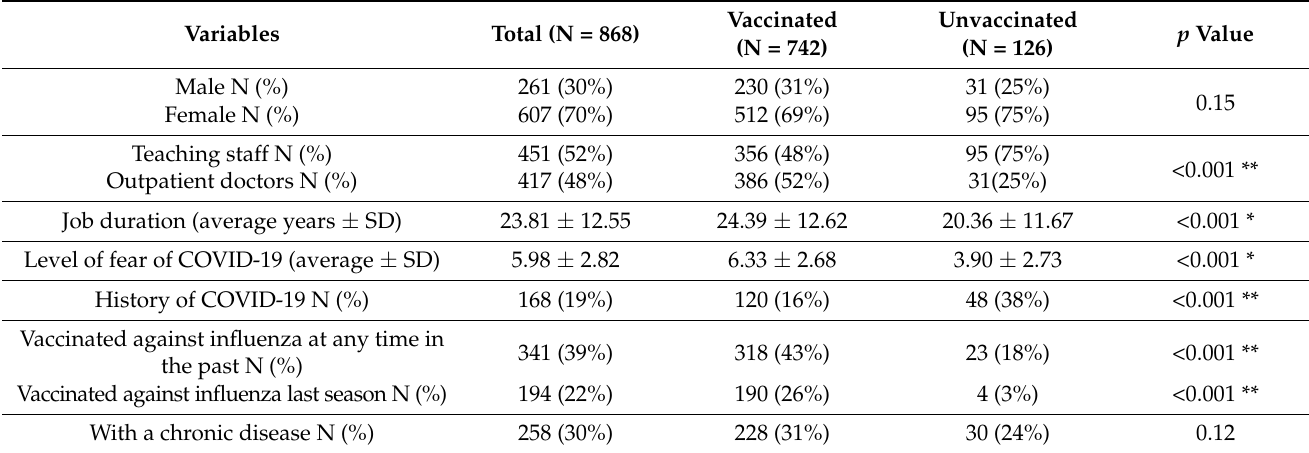
Table 1. Socio-demographic characteristics of respondents vaccinated against COVID-19.